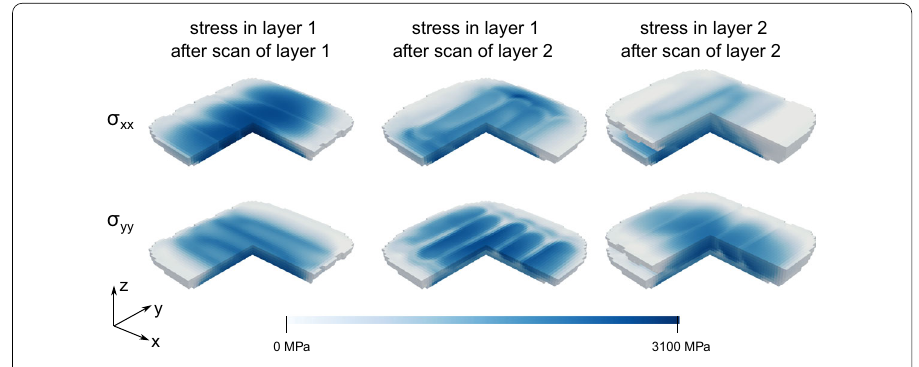
Fig. 22 Multiple tracks per layer: stress distribution on consolidated part geometry after scanning layer 1 (first column) and layer 2 (second and third column). A quarter of the geometry is cut out for visualization